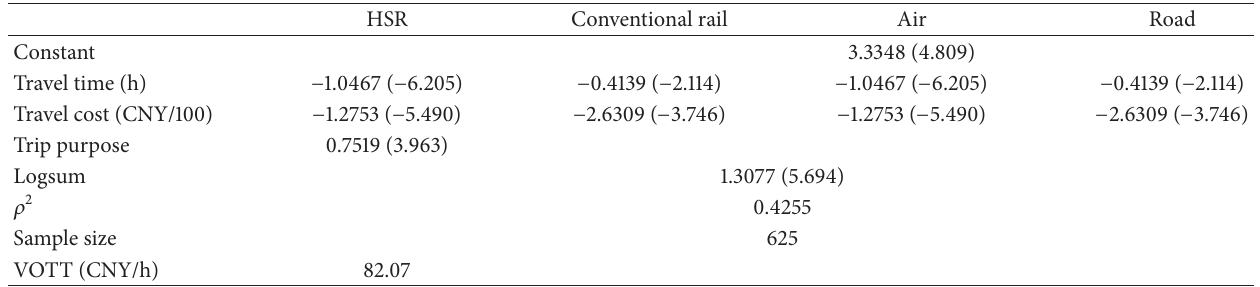
Table 5: Estimations of high-income group ( t -statistics are in